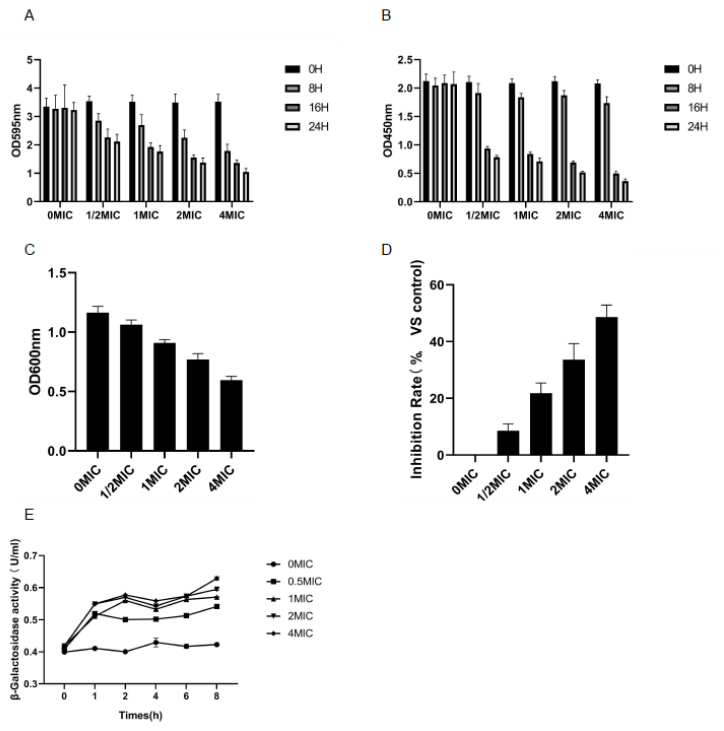
Figure 2. Disruption of Pseudomonas D4 cell membrane and biofilm by lemon verbena essential